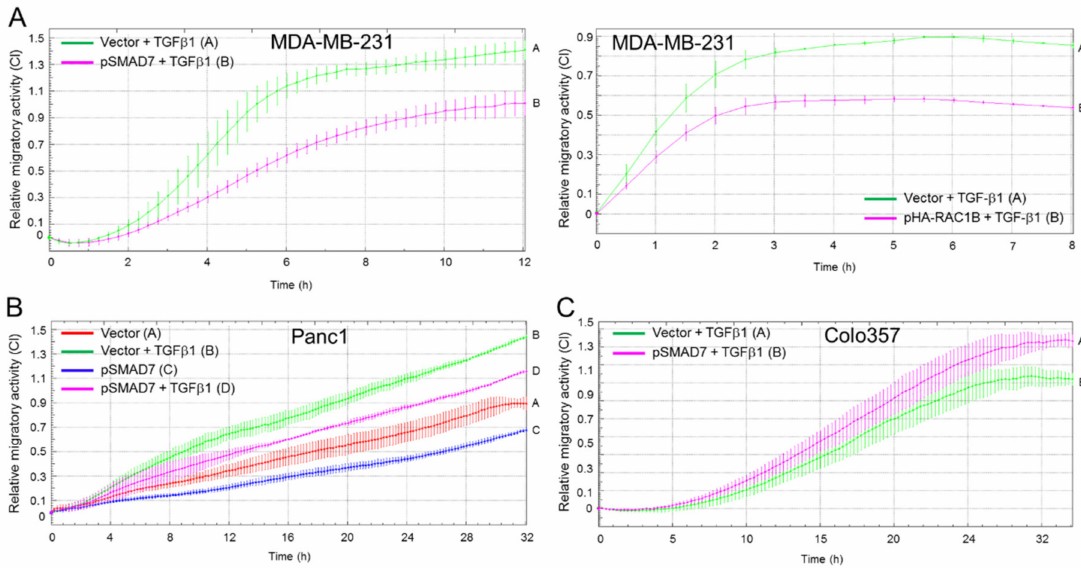
Figure 6. E ff ect of ectopic SMAD7 expression on TGF β 1-induced migration in Panc1, MDA-MB-231, and Colo357 cells. ( A ) MDA-MB-231 cells were transfected twice with either empty vector or a SMAD7 expression vector (pSMAD7, left-hand graph), or pHA-RAC1B (right-hand graph) as control, and 48 h later subjected to migration assay in the presence of TGF β 1. Di ff erences between vector and SMAD7 transfected cells are first significant at 04:00 (left-hand graph) or 01:30 (right-hand graph) and all later time points. ( B ) Panc1 cells were transiently transfected with pSMAD7 or empty pcDNA3 vector and 48 h later subjected to real-time cell migration assay on the xCELLigence platform in the absence or presence of TGF β 1. Di ff erences between vector + TGF β 1-treated cells (green curve, tracing B) and pSMAD7 + TGF β 1 transfected cells (magenta curve, tracing D) are first significant at 11:00 and all later time points. ( C ) As in ( A , left-hand graph), except that Colo357 cells were used. The recorded migratory activities of SMAD7-transfected Colo357 cells were not significantly di ff erent from those of controls before the 20 h time point. In all panels, data are derived from one representative experiment and are the mean ± SD from 3–4 wells per condition. Note that in ( A , C ), only TGF β 1-treated cells are shown. Successful overexpression of SMAD7 in all three cell lines, and of HA-RAC1B in MDA-MB-231 cells, was verified by